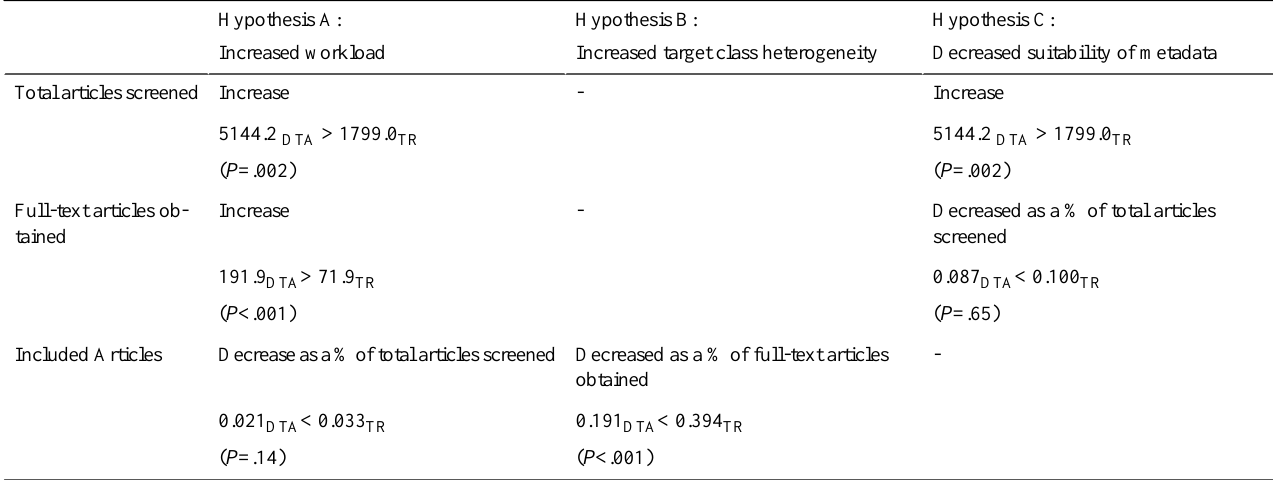
Table 7. Summary linking each hypothesis, expected manifestation, and literature screening